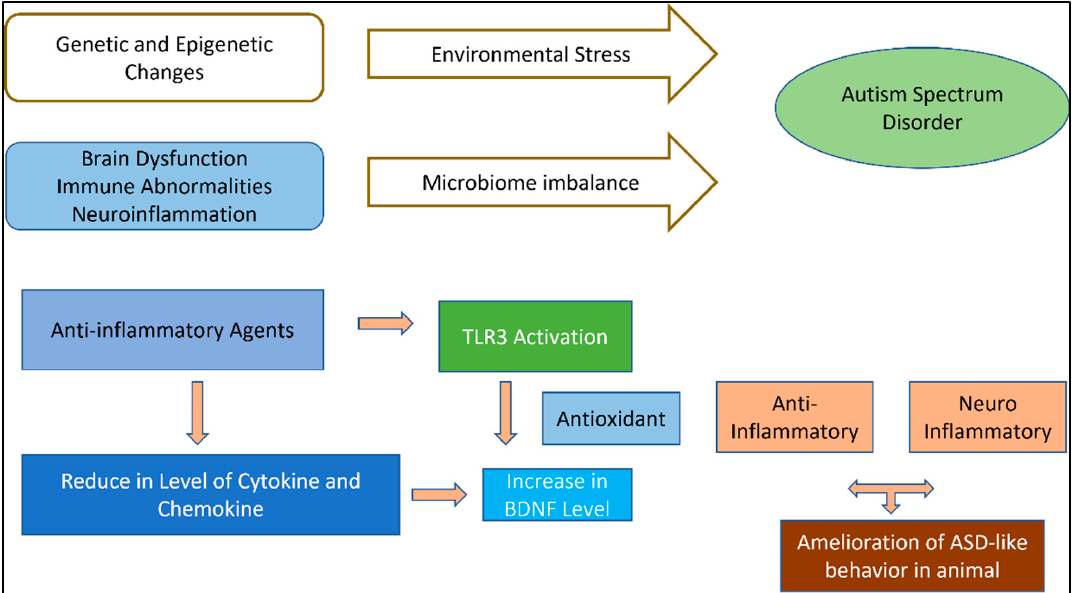
Figure 2. Pathogenetic mechanisms of ASD and related anti-inflammatory agent action with potential therapeutic effects illustrated in ASD animal models.